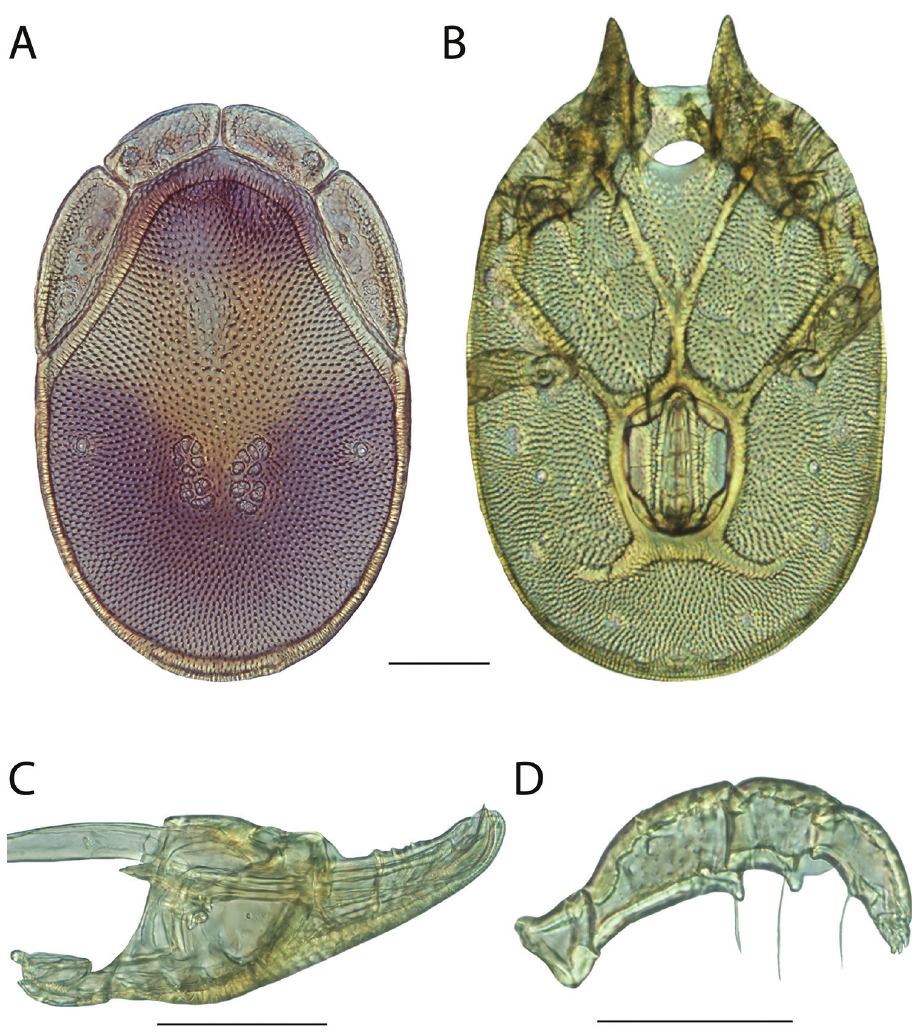
Figure 74. Torrenticola erectirostra sp. n. male: A dorsal plates B venter (legs removed) C subcapitulum D pedipalp (setae not accurately depicted). Scale = 100